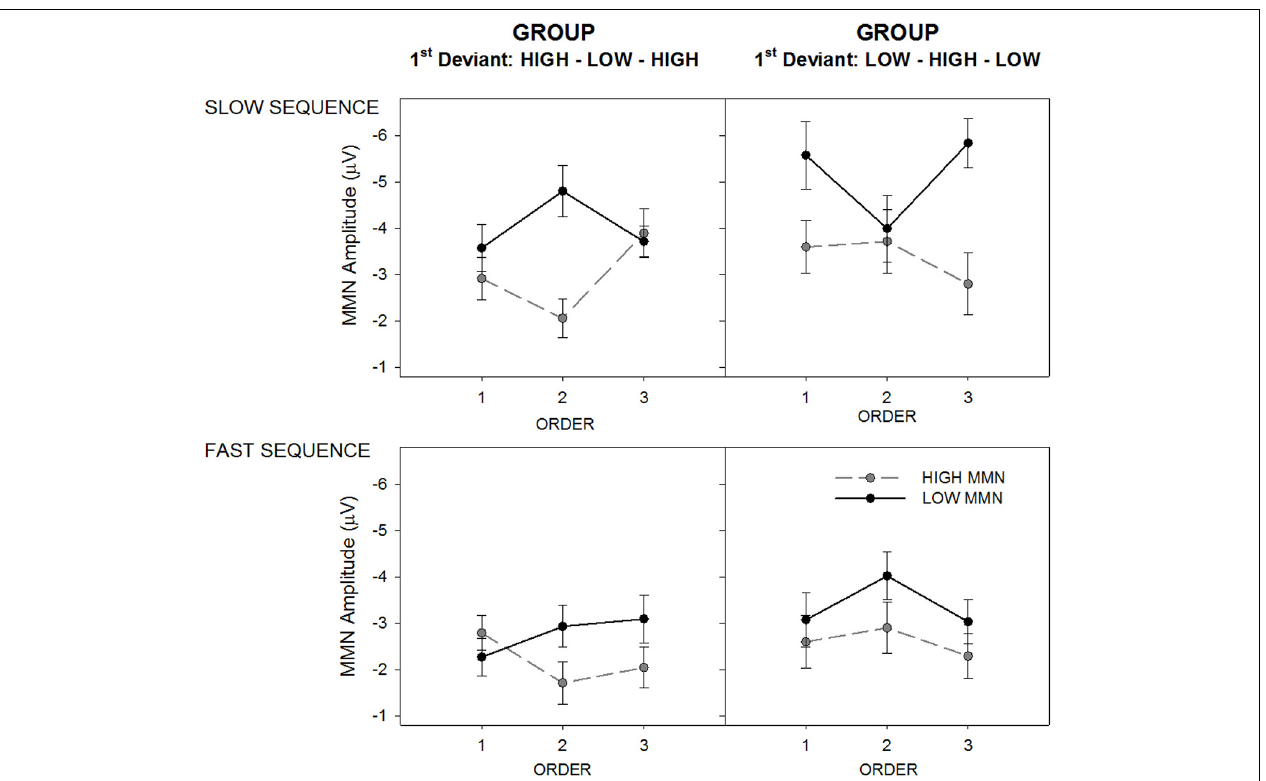
FIGURE 4 | Mean MMN amplitude for deviant high (gray/broken lines; “HIGH MMN”) and low (black full lines; “LOW MMN”) pitched tones, separately for the group hearing sequences with the High-Low-High 1st deviant order (left panels) and Low-High-Low 1st deviant order